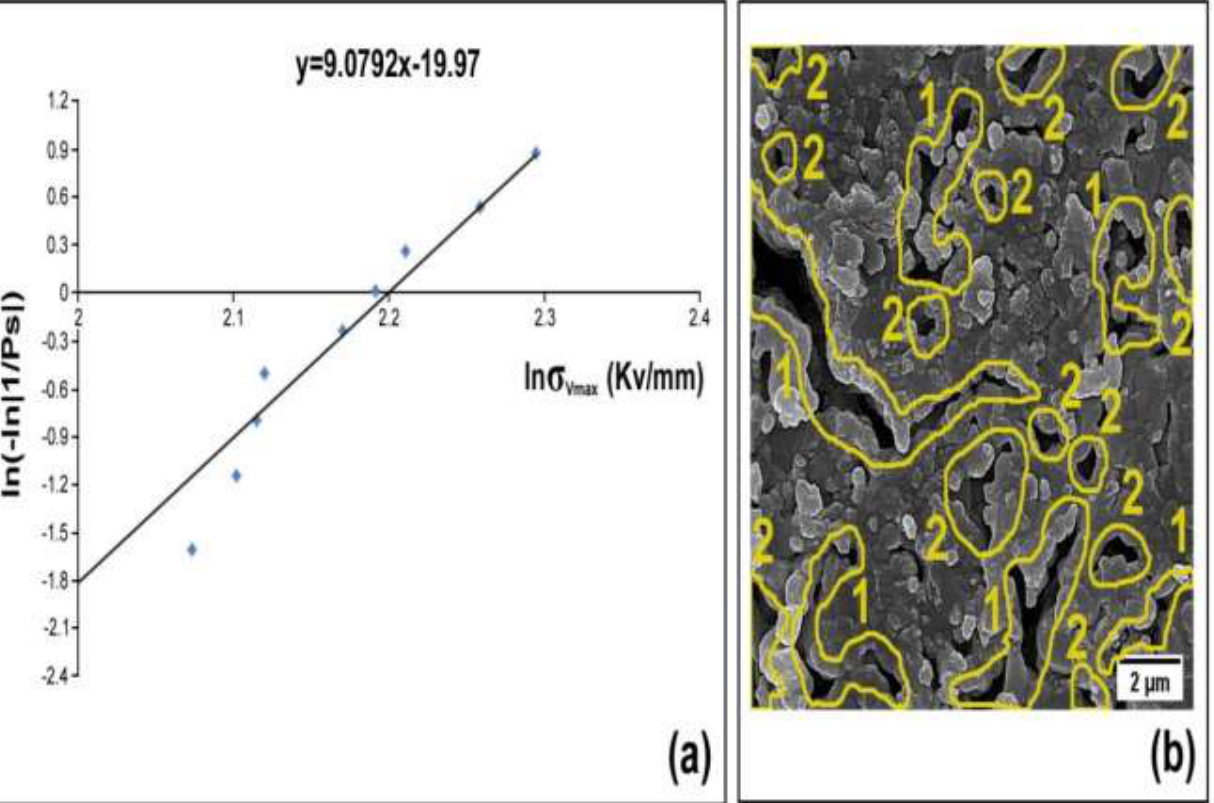
Figure 3: (a) Weibull modulus determination for LC2S as homogeneity indicator. (b) FESEM image for LC2S microstructure 2